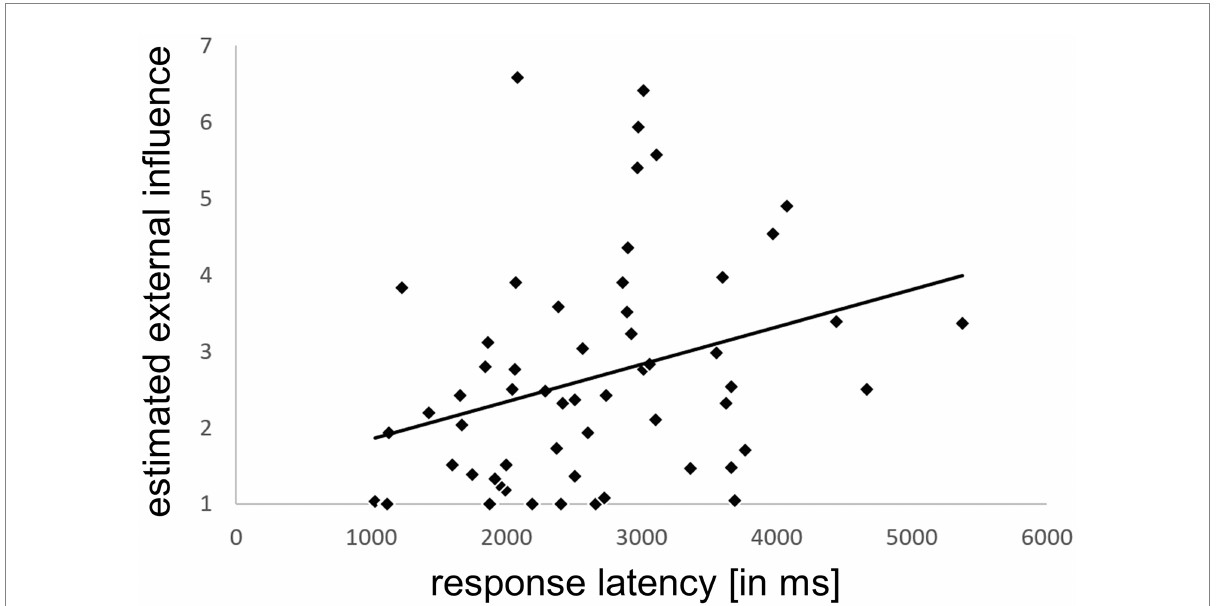
FIGURE 6 Correlation of the estimated external influence with response latency. The average external influence rating per participant correlated significantly with the corresponding average response latency for estimating this influence (across all four conditions). Due to non-normally distributed data nonparametric testing was performed ( r S = 0.392, p = 0.002). ms = milliseconds.